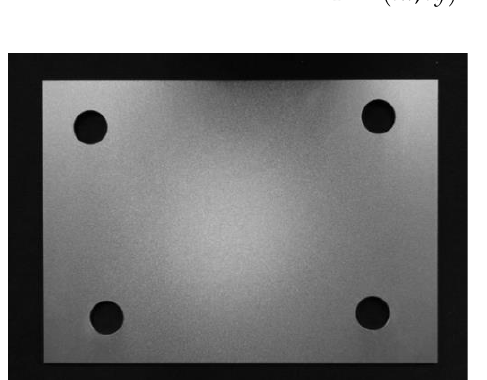
Figure 9. Calibration metal plate.